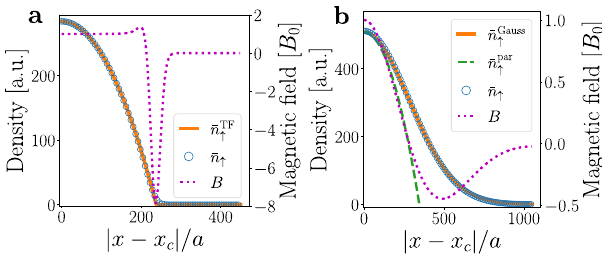
Fig. 5 Condensate density pro fi les and effective magnetic fi eld. a Density pro fi le of the ↑ atoms in the Thomas – Fermi regime for a strength of harmonic trap V x = 10 − 6 J / a 2 , a number of bosons N ↑ = 1.2 × 10 5 , N x = 601 sites and an onsite interaction U = 10 − 4 J . b Density pro fi le of the ↑ atoms in the non-interacting regime for V = 5.8 × 10 − 11 J / a 2 , x N ↑ = 4.8 × 10 5 , N x = 1401. The dashed line is the approximate parabolic pro fi le valid for ∣ x − x c ∣ ≪ ξ , where ξ is the Gaussian width (see Eq. (27)). The resulting magnetic fi eld (dotted line) is shown in both panels in units of B fi eld at the center of the trap, x 0 , the value of the magnetic